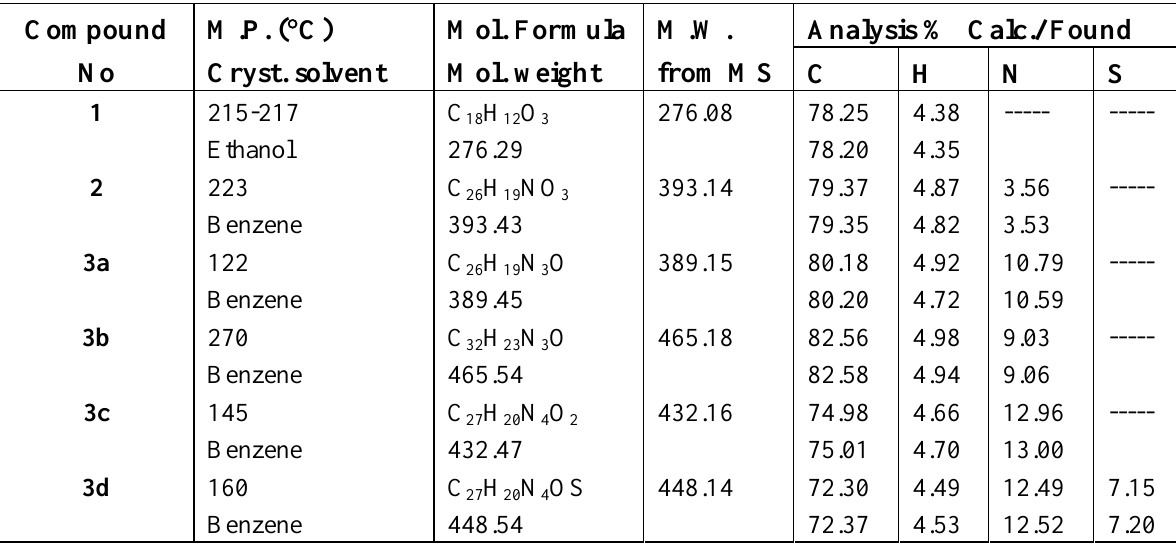
Table 1. Physical properties, mass spectral data and elemental analyses for compounds 1-3